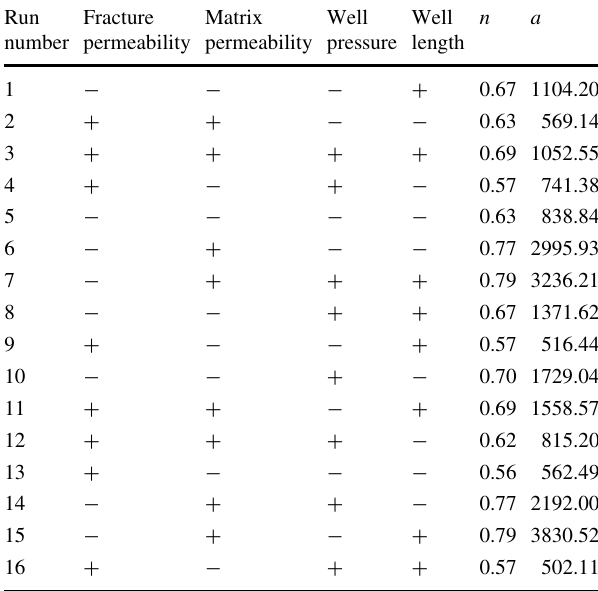
Table 10 Design table for variables with the main effect on the hyperbolic constant n and